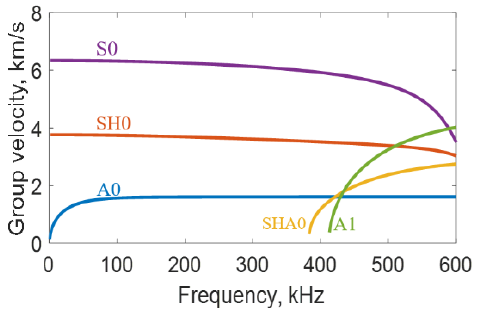
Figure 15. Group velocity dispersion curve for 2 mm composite coupon having a stacking sequence of [ − 45/90/+45/0] 2S.